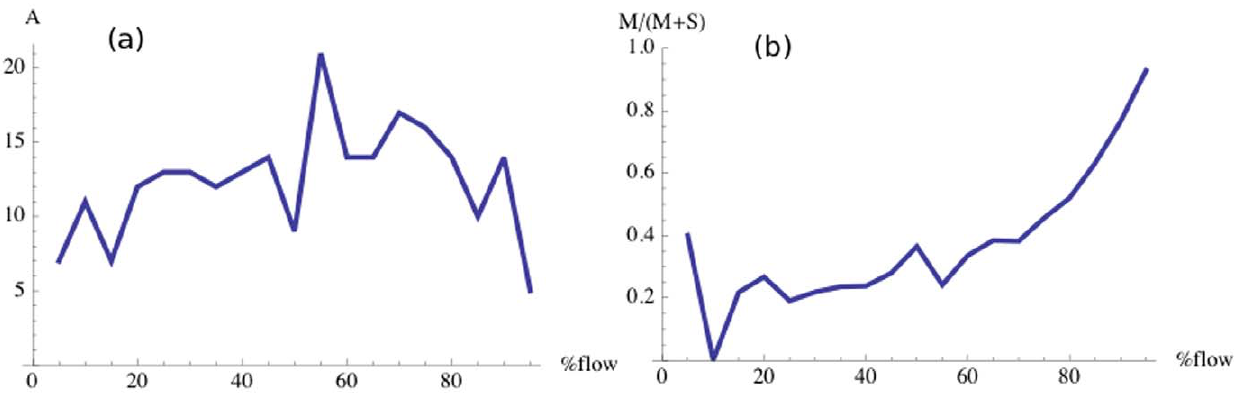
Figure 9. Evolution of the number of sources and their type. (a) Number of new sources ( A ) versus the total flow W . (b) Fraction of existing sources whose type is changing ( M ) when the total flow varies from W to W z d W . Here d W ~ 5% .